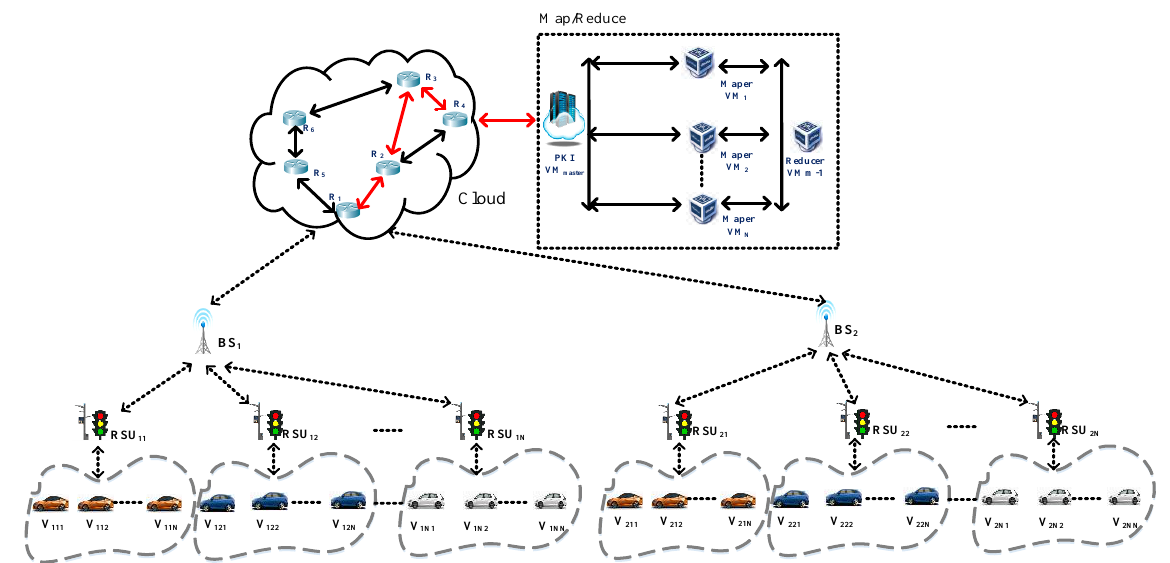
Figure 3. The multi-level security architecture.